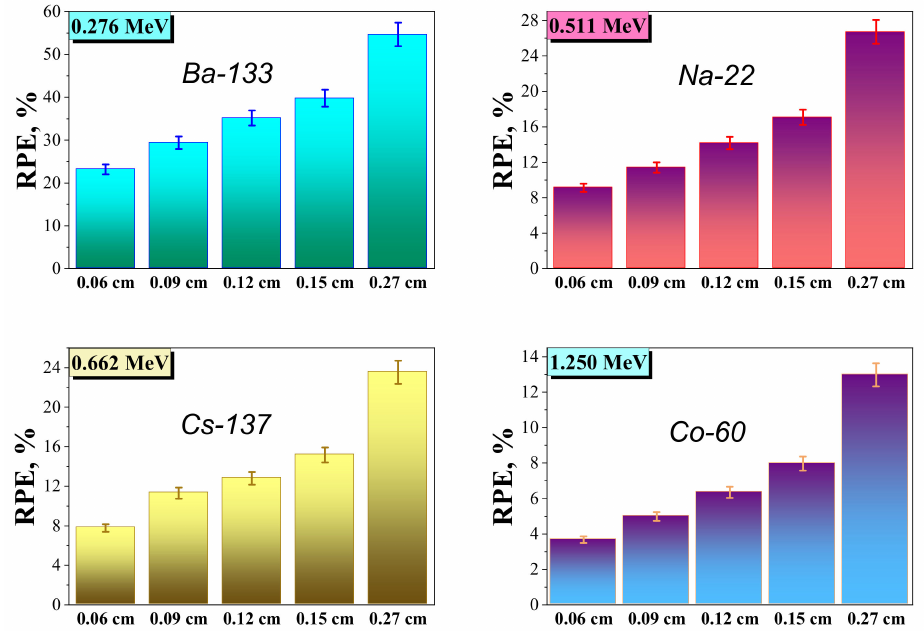
Figure 10. RPE values of the W–Cu composite with different thicknesses depending on the incident gamma photon energy. Table 4. Radiation protection efficiency of the W–Cu composites with various thicknesses. Energy,